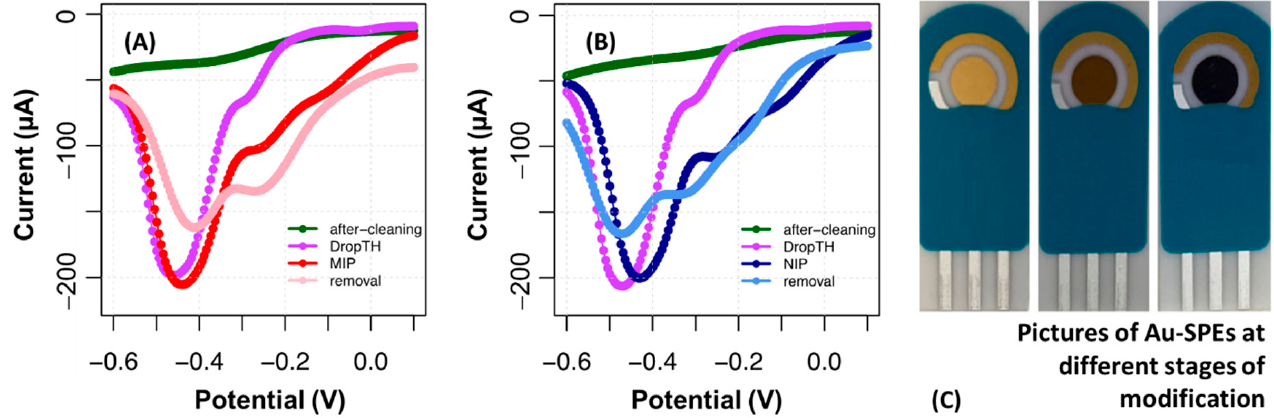
Figure 7. DPV voltammogram of Au-SPE after cleaning of surface (green), PTH (violet), electropolymerizing TH with or without CA 19-9 (red, MIP, and blue, NIP), and removing the template (coral, MIP, and light-blue, NIP). MIP represented in ( A ) and NIP in ( B ). SPE with the color changes in the working electrode in the different construction phases ( C ).